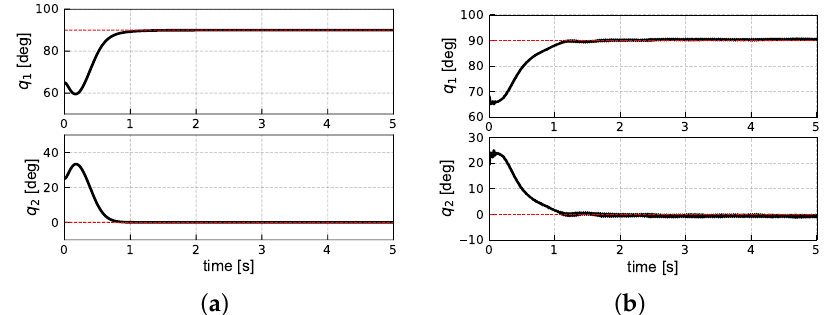
Figure 9. Case B1: Angular positions: ( a ) simulation, ( b ) experiment.